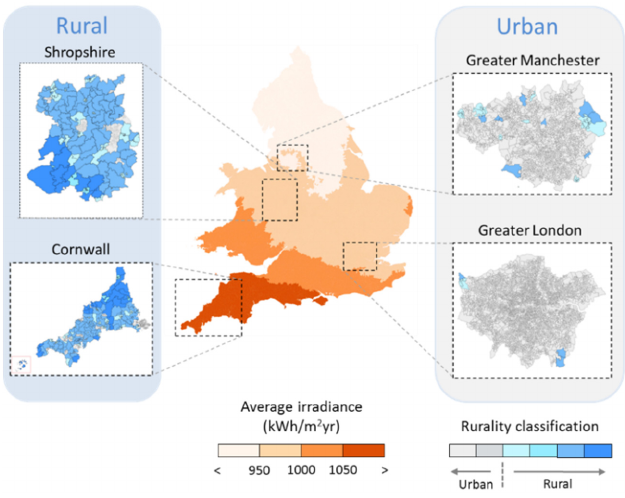
Figure 2. Selection of case study areas for domestic and non ‐ domestic photovoltaics (PV).